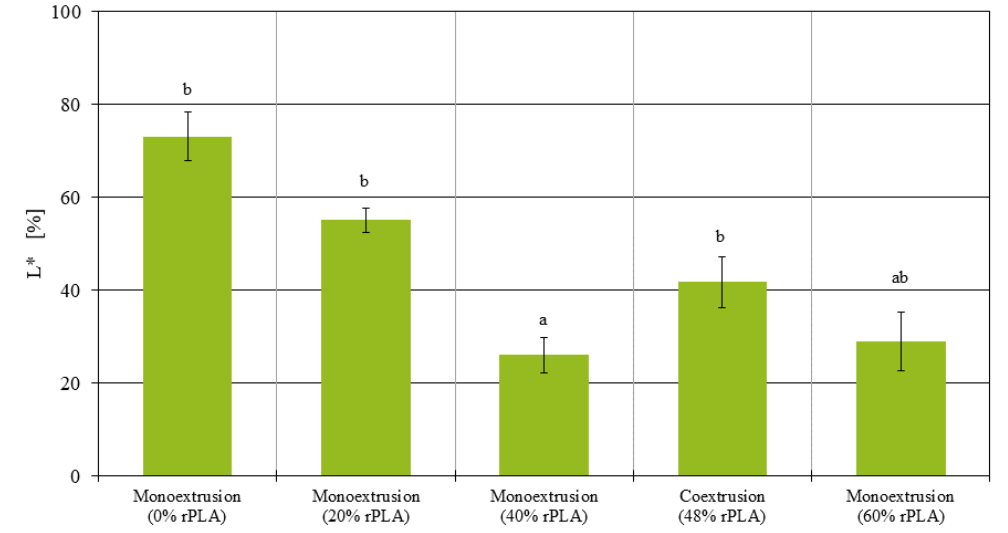
Figure 12. Reflectance of all additively manufactured tensile testing